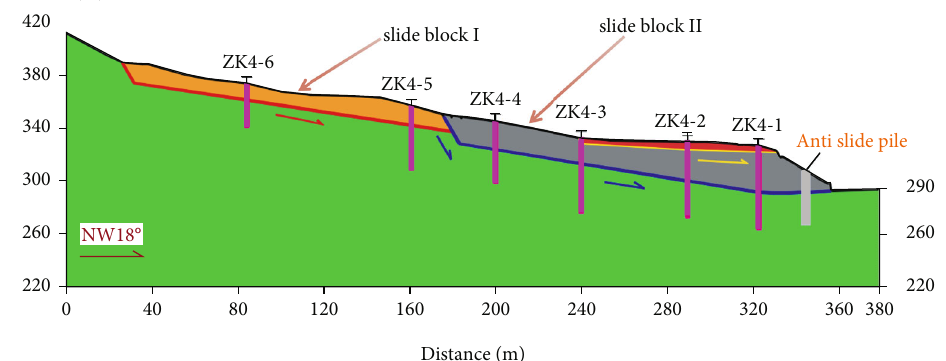
Figure 14: Schematic diagram of sliding surface